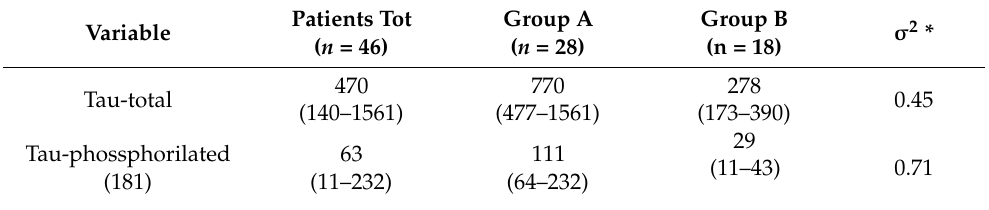
Table 2. Average values recorded for each variable. The minimum and maximum values are shown in parentheses; σ 2 is the variance of the values according to “one-way ANOVA”.